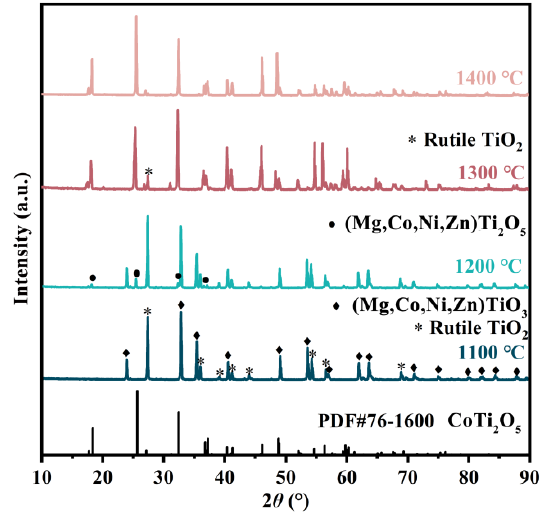
Fig. 2 XRD patterns of AT2 after sintering at 1100, 1200, 1300, and 1400 ℃ for 2